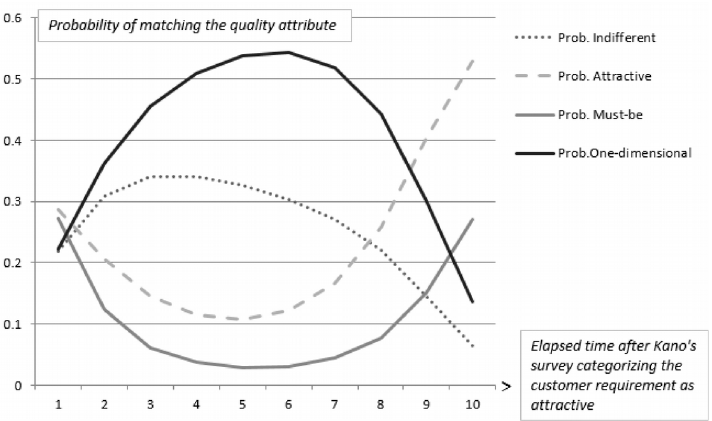
Figure 5. Expected trajectories of customer requirements designated as attractive